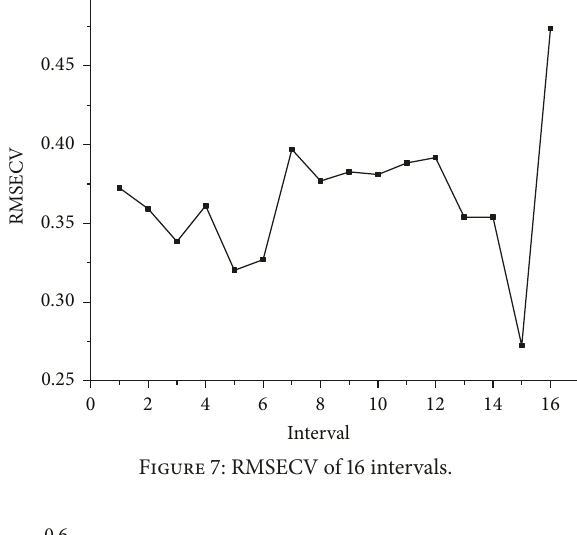
Figure 5: Plot of 12 selected wavelengths by UVE-SPA. Columns represent selected wavelengths.